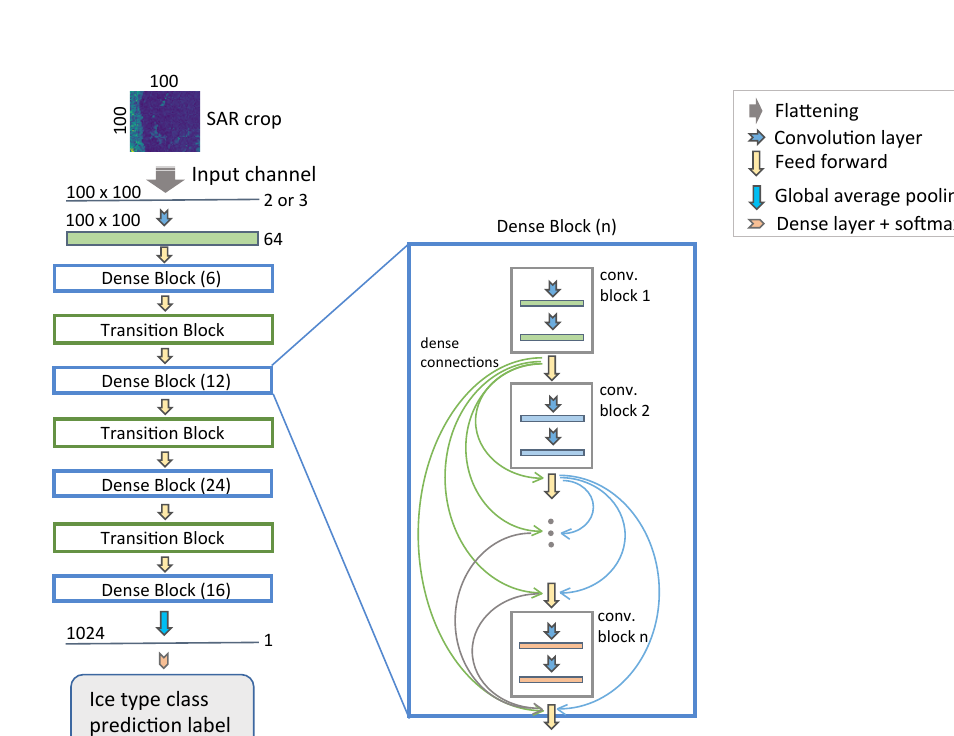
Figure 4. DenseNet model: The model consists of a number of dense blocks connected by transition blocks that maps a SAR sub-image to a predication label. A representative model used in this work consists of approximately 7 million